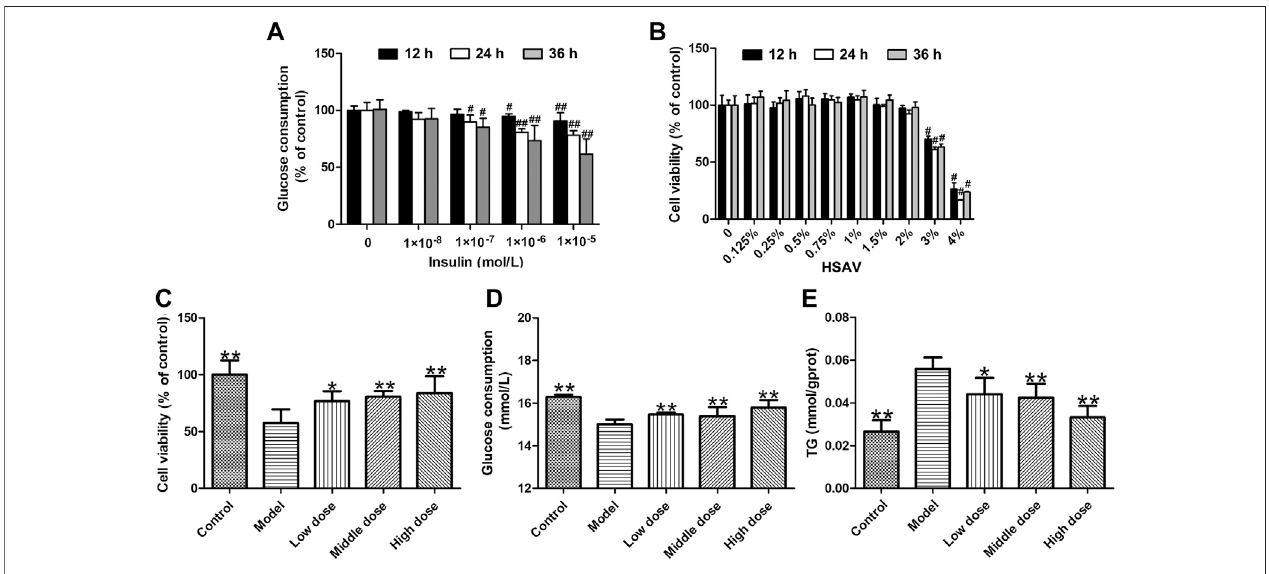
FIGURE 1 | Effects of Hengshun aromatic vinegar (HSAV) on insulin-induced HepG2 cells. (A) Effect of insulin on glucose consumption of HepG2 cells; (B) Cytotoxicity effect of HSAV on HepG2 cells; Effect of HSAV on cell viability (C) , glucose consumption (D) and TG content (E) in insulin-induced HepG2 cells. Data are presented as the mean ± SD (n (cid:2) 6). # p < 0.05 and ## p < 0.01 compared with control group; * p < 0.05 and ** p < 0.01 compared with model